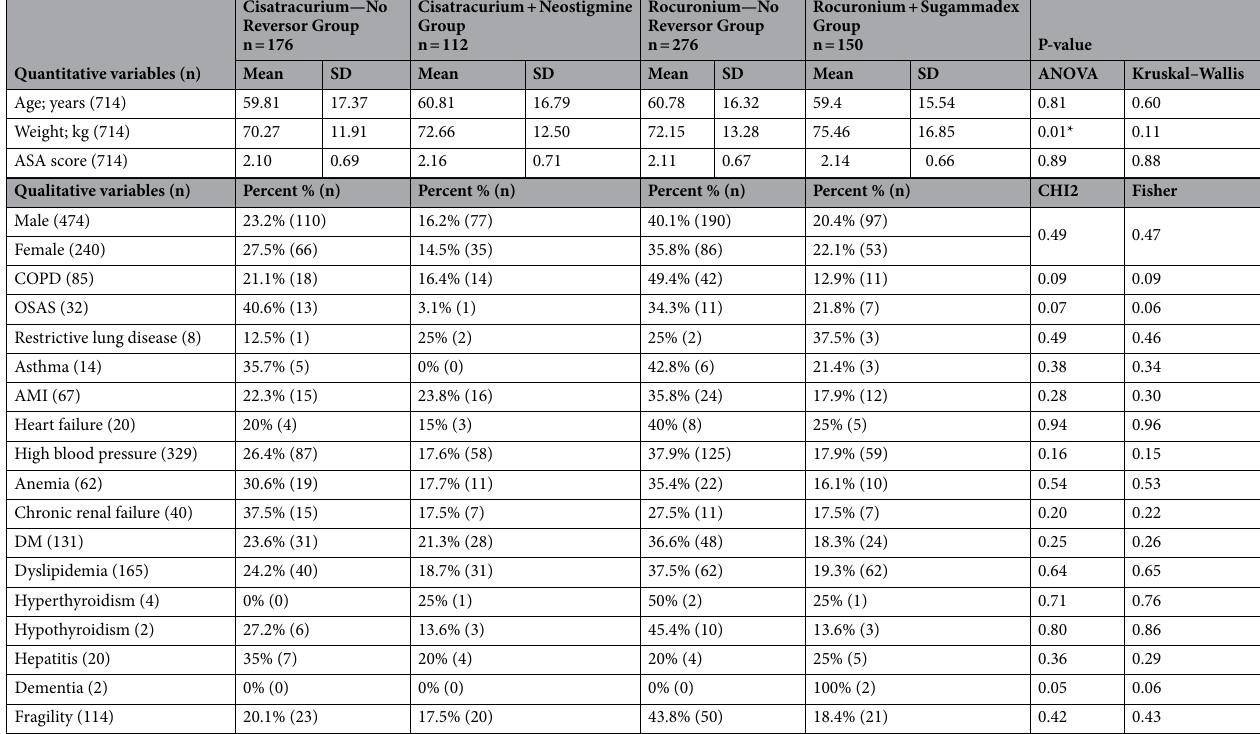
Table 1. Homogeneity and comparison of demographic data and comorbidities between groups. Basic descriptives and tests for the demographic and comorbidities data for each group. All variables have no significant relationship with the groups. In other words, for each of these variables, there was no significant difference between the proportion of patients that were assigned to each type of neuromuscular blocking agent and pharmacological reversal. Quantitative variables: mean and standard deviation (SD) for each group, along with comparing means tests (ANOVA or Kruskal–Wallis). Qualitative variables: quantity or absolute frequency (n), proportion or relative frequency (%—percent) for each group, along with independence tests (Chi2 or Fisher). *Significance defined as p-value < 0.05. ASA American Society of Anesthesiologists score, COPD Chronic Obstructive Pulmonary Disease, OSAS Obstructive Sleep Apnea Syndrome, AMI Acute Myocardial Infarction, DM Diabetes